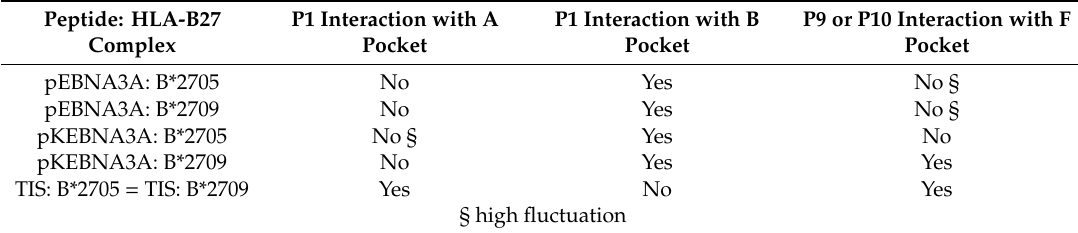
Table 1. Peptide position in the binding groove.